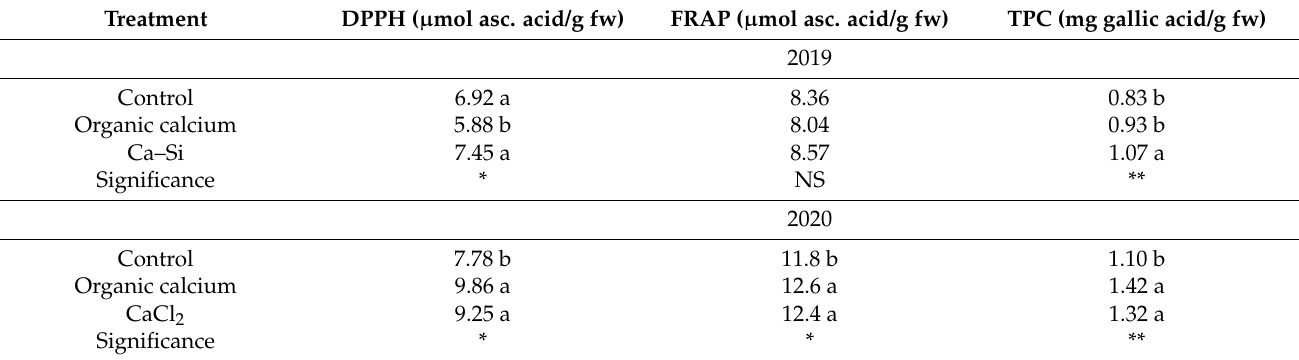
Table 4. The effect of the Ca formulation on the total antioxidant activity (DPPH and FRAP assays) and total phenolic content (TPC) at the Agios Vlasios